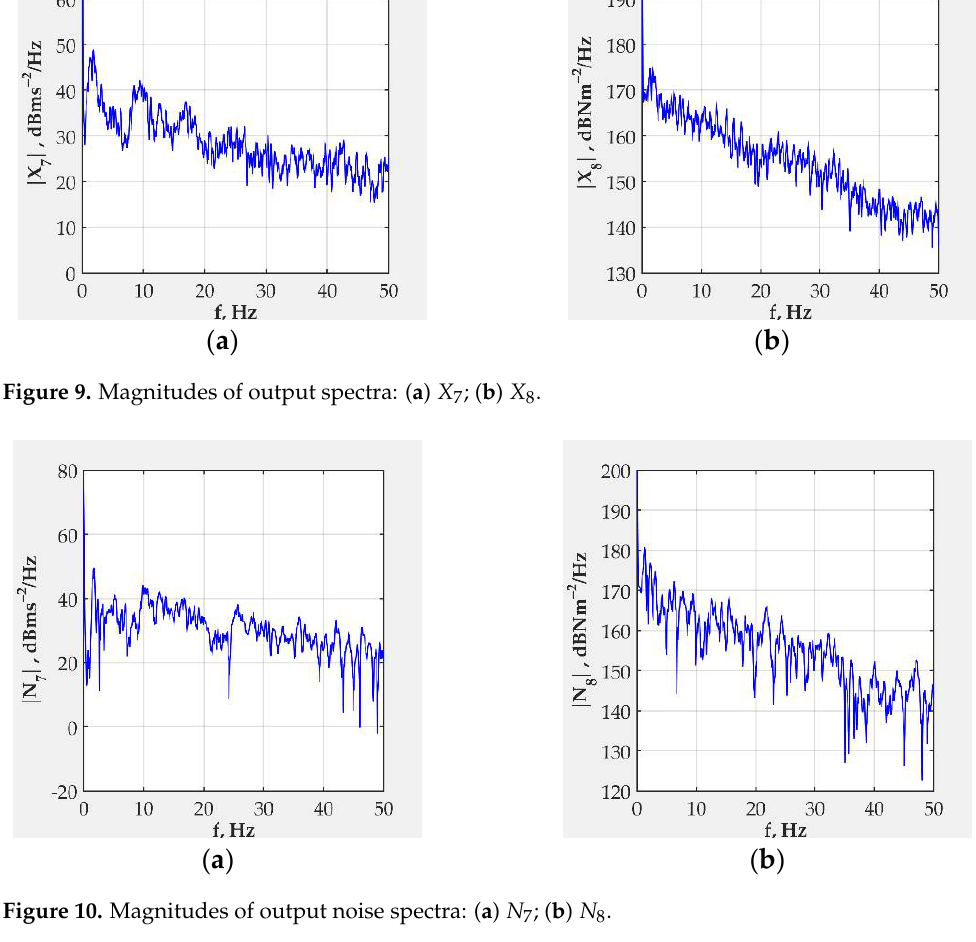
Figure 10. Magnitudes of output noise spectra: ( a )